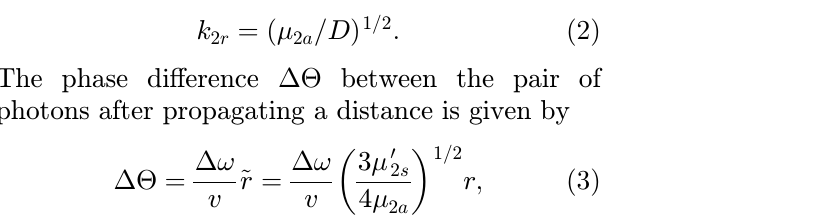
Fig. 1. Experimental setup of DPPDW: TFL, two-frequency laser; Pol, polarizer; BS, beam-splitter; MO, microscope ob- jective; PMT, photomultiplier tube; Det, photodetector; PA, preampli¯er; and LIA, lock-in